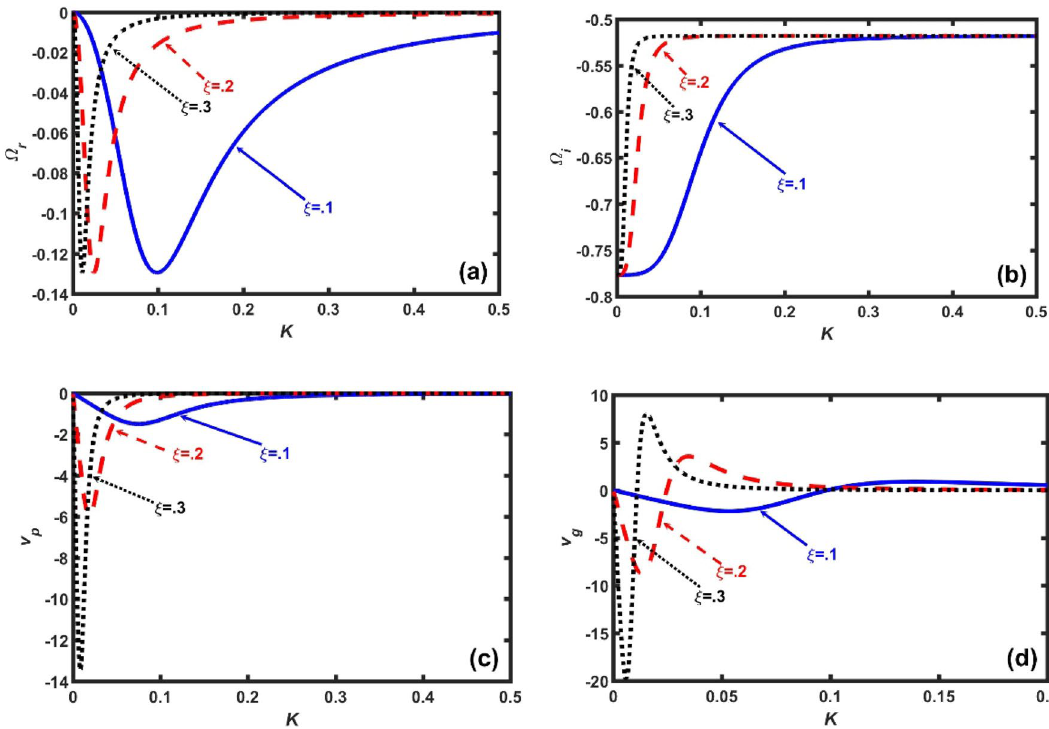
5 10 14 kg m −3 (fixed). The different lines link to different Jeans- = × 0.1 (solid blue line), ξ =